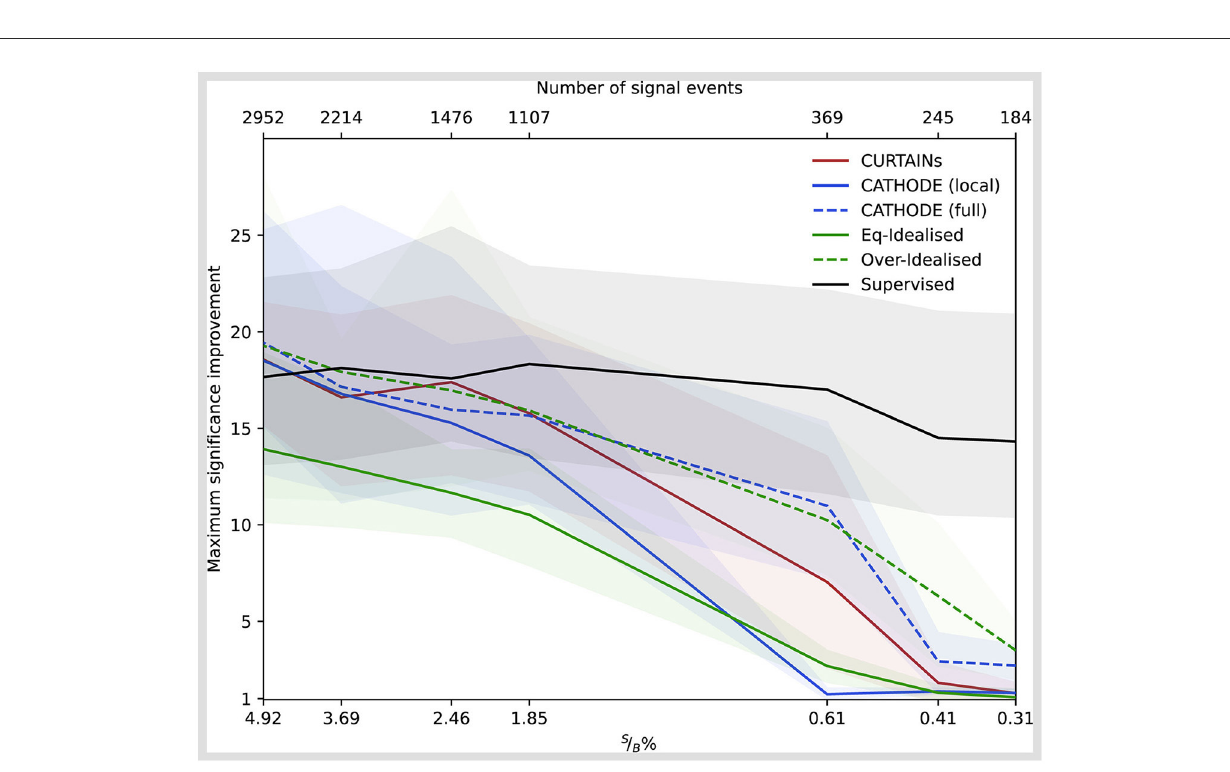
FIGURE7 The significance improvement as a function of decreasing signal purity (raw signal events) for the different background template models [C URTAIN s—red, C ATHODE (local)—blue, Eq-Idealised—green, Over-Idealised—dashed green] and a fully supervised classifier (black). All classifiers trained in the signal region 3,300 m JJ < 3,700 GeV for varying levels of signal doping. The solid lines show the mean value of fifty classifier trainings ≤ with different random seeds. The uncertainty encompasses 68% of the runs either side of the mean.